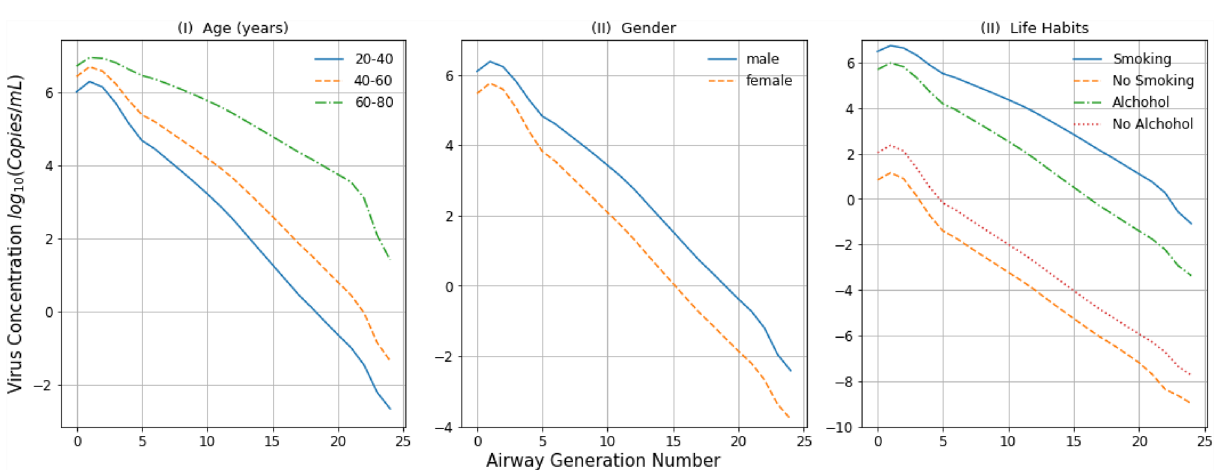
Figure 8. Change in virus concentration along the respiratory tract associated with changing age ( I ), gender ( II ), and lifestyle habits ( III ) when the exposure level C 0 is fixed to 10 7 Copies/ml and the virus concentration is the average value computed for 21